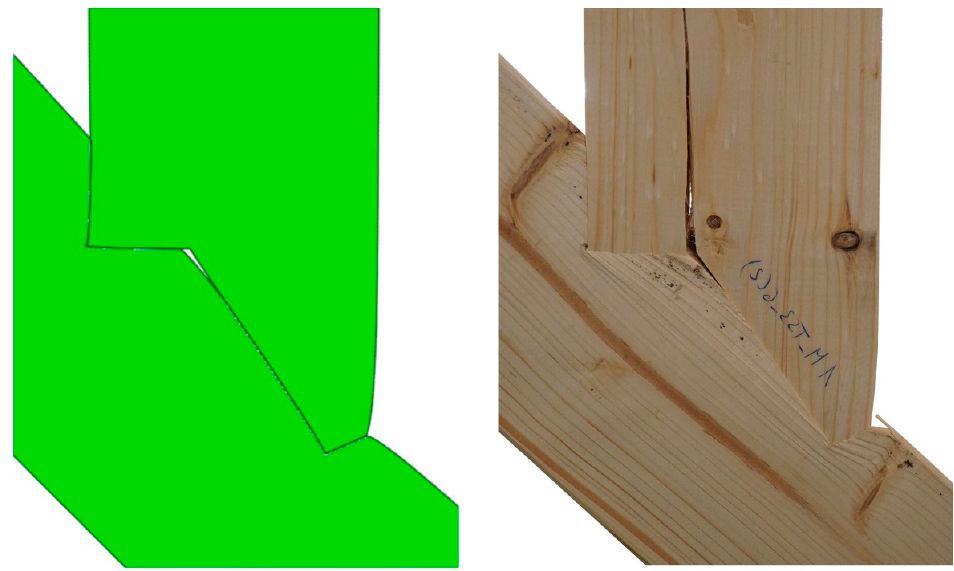
Figure 23. ( Left ): Deformation of numerical model; ( Right ): failure of double-step joint in the experiment.